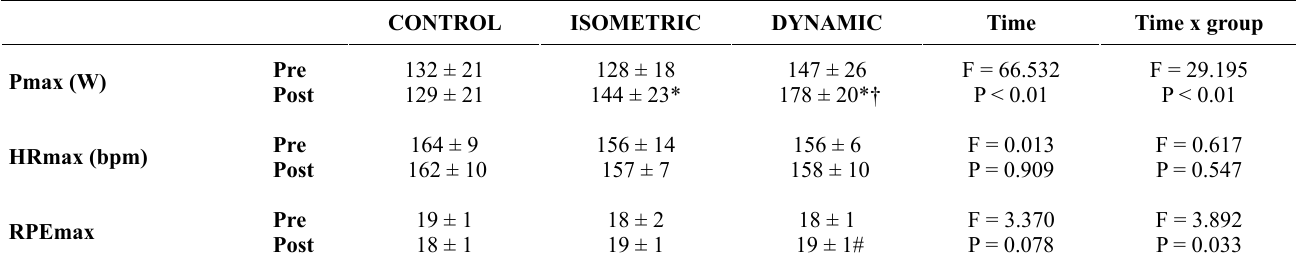
Table 4. Mean (±SD) of aerobic fitness variables obtained on maximum aerobic incremental test (MAIT) according to interventions. CONTROL ISOMETRIC